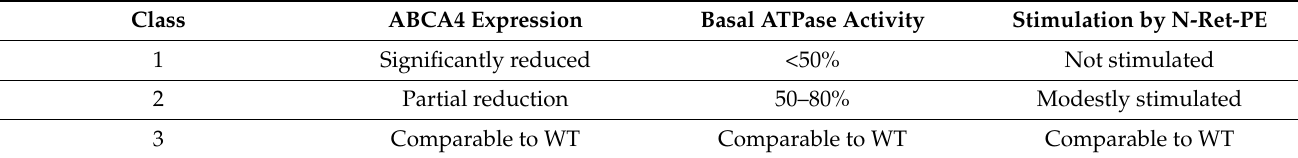
Table 5. A summary of the severity classification of the variants described by Curtis et al.